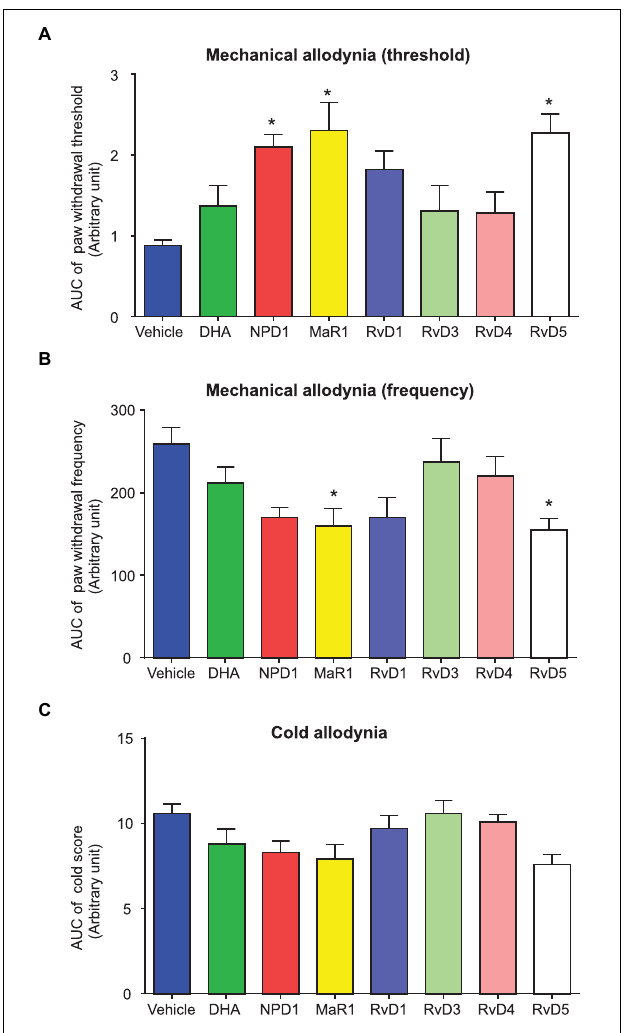
FIGURE 5 | Area under curve (AUC) comparison of distinct post-treatment effects of DHA and DHA-derived SPMs on fPOP. (A–C) AUC showing the effects of post-surgical IT treatment of DHA (500 µ g, 10 µ l) and NPD1, MaR1, RvD1, RvD3, RvD4, and RvD5 (500 ng, 10 µ l), given 2 weeks after bone fracture surgery on mechanical and cold allodynia. AUC data were collected at 1–5 h after the drug injection. ∗ P < 0.05 vs. vehicle (10% ethanol), two-way ANOVA followed by Bonferroni test, n = 5–7 mice/group. Data are presented as mean ±